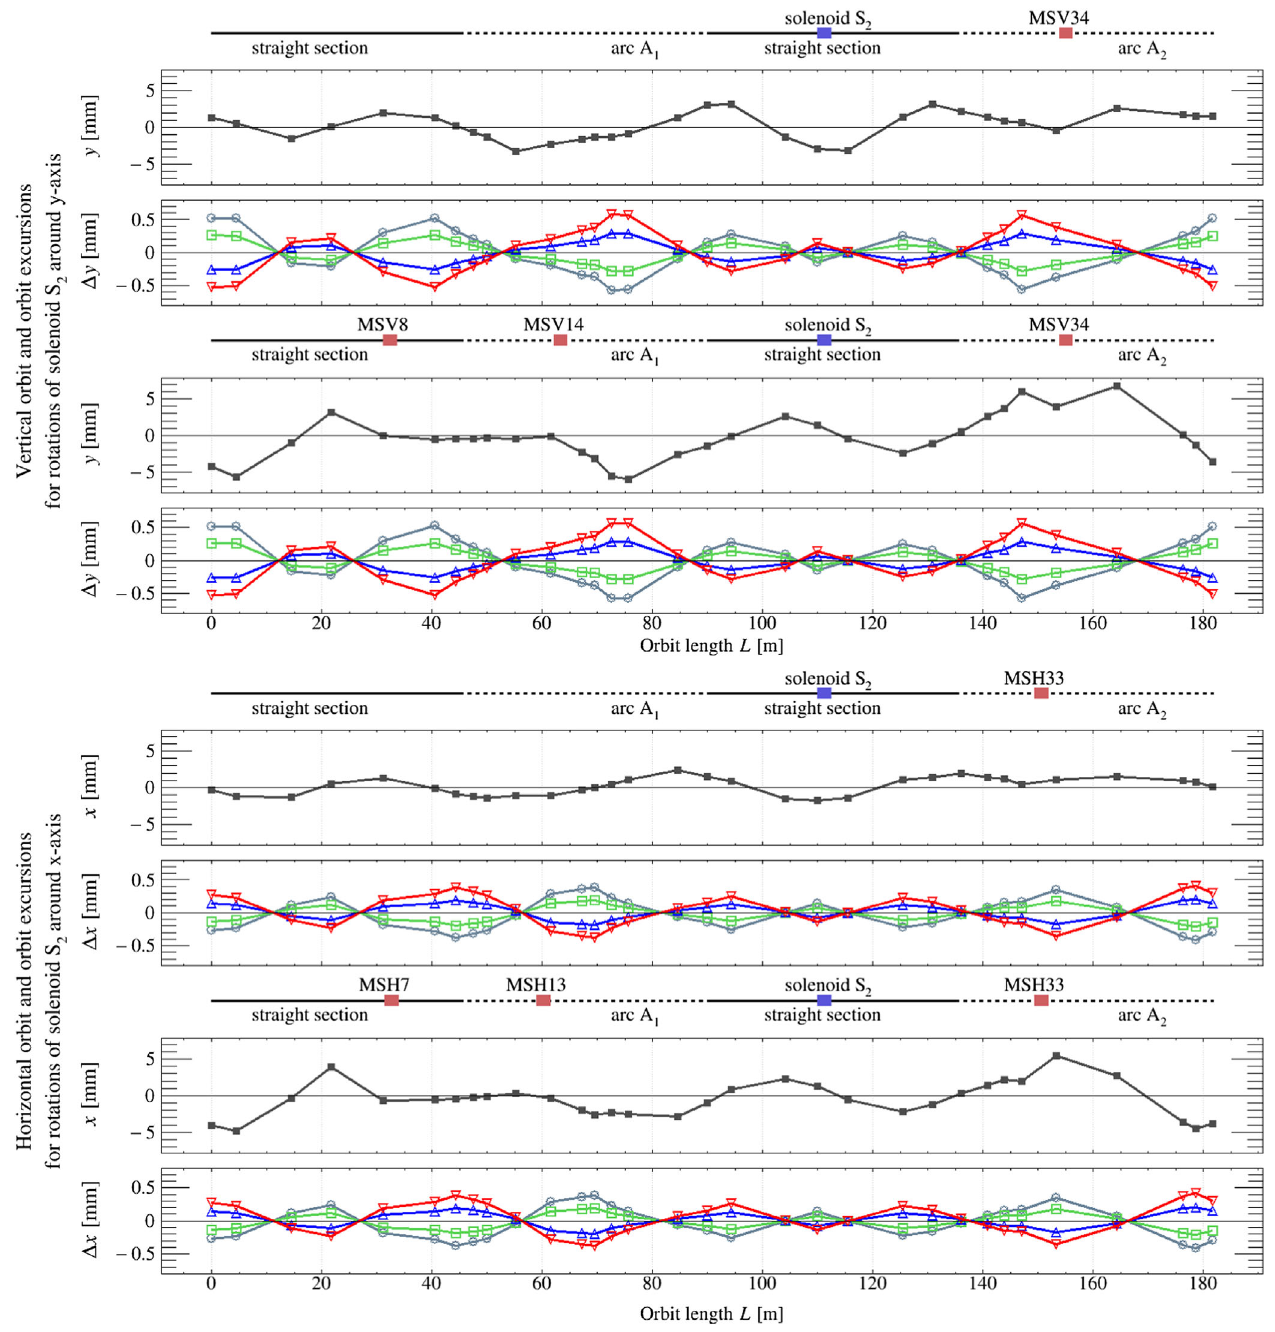
FIG. 8. Top four panels: absolute beam positions y ½ mm (cid:2) indicate the vertical orbits for the vertical steerer sets 1 and 2 (Table III), when solenoid S 2 is switched off. The panel for Δ y ½ mm (cid:2) shows the vertical orbit excursions with respect to the absolute beam positions when 12 . 98 mrad, and rotated around the y -axis by ξ − 8 ð ○ Þ ; − 4 ð □ Þ ; 4 ð △ Þ , and solenoid S 2 is switched on with a spin kick angle χ y ¼ AI ¼ 8 ð ▽ Þ mrad. The observed excursions are linear in ξ . Bottom four panels: Same as top four panels, but here for rotations of solenoid S 2 y − 8 ð ○ Þ ; − 4 ð □ Þ ; 4 ð △ Þ , and 8 ð ▽ Þ mrad for the steerer sets 3 and around the horizontal x -axis with ξ x ¼